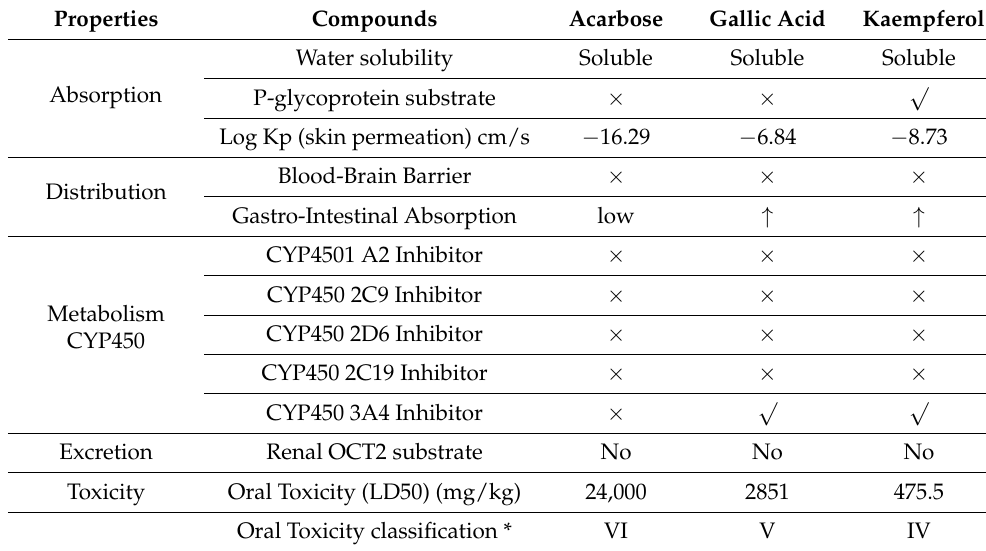
Table 4. ADME Profiling of candidate